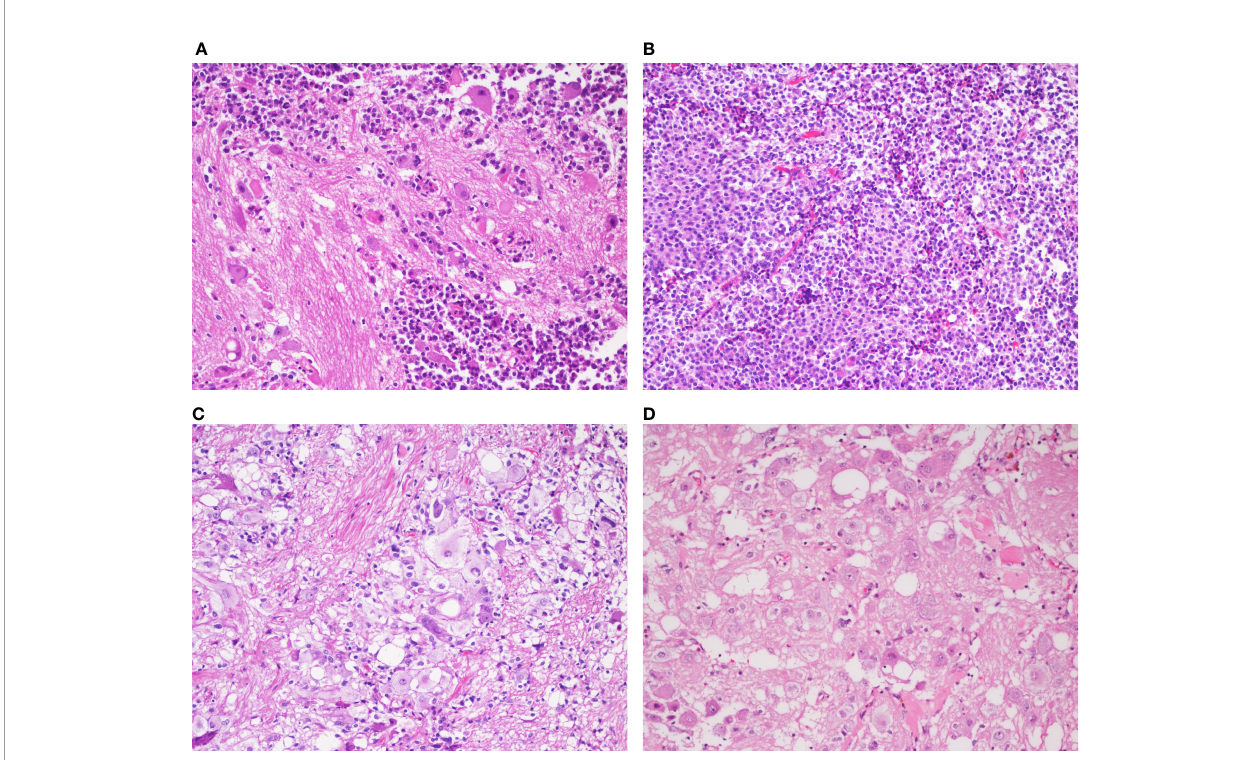
FIGURE 2 | Histopathological analysis of the mixed gangliocytoma-pituitary adenoma in a representative case (Case 3) (A) Two distinct mixed neoplastic cell populations are observed. (B) The adenomatous component consists of small monomorphic cells with oval nuclei and eosinophilic cytoplasm. (C) Binucleated cells and masses of neuropils are detected in the neural component. (D) The ganglionic cells are large, immature with abundant cytoplasm and decentralized nuclei containing prominent nucleoli. [ (A – D) , magni fi